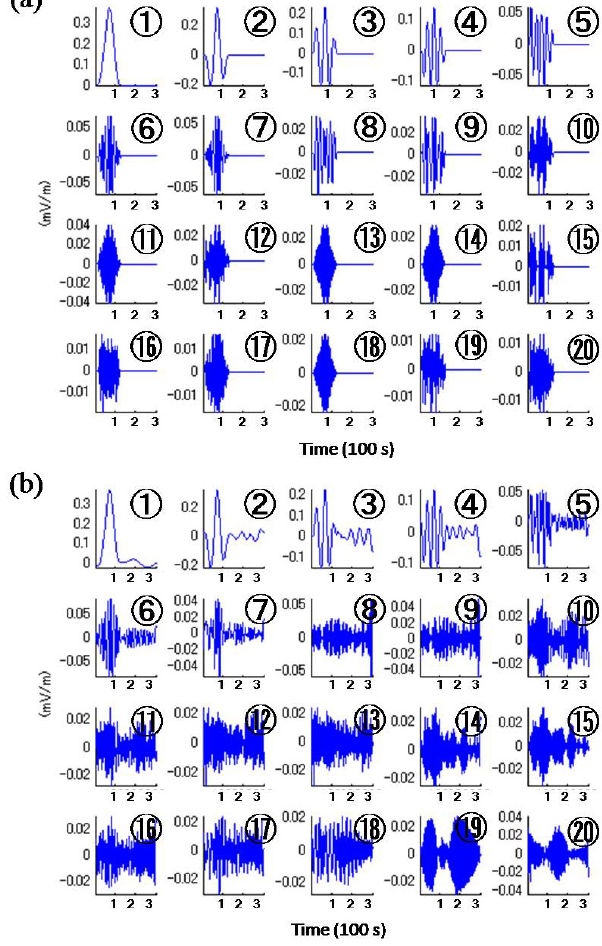
Fig. 7. Decomposed components using SSA. (a) 20 decomposed components for Fig. 6a. (b) 20 decomposed components for Fig. 6c. The number shown in each panel indicates the ith principal compo- nent of SSA